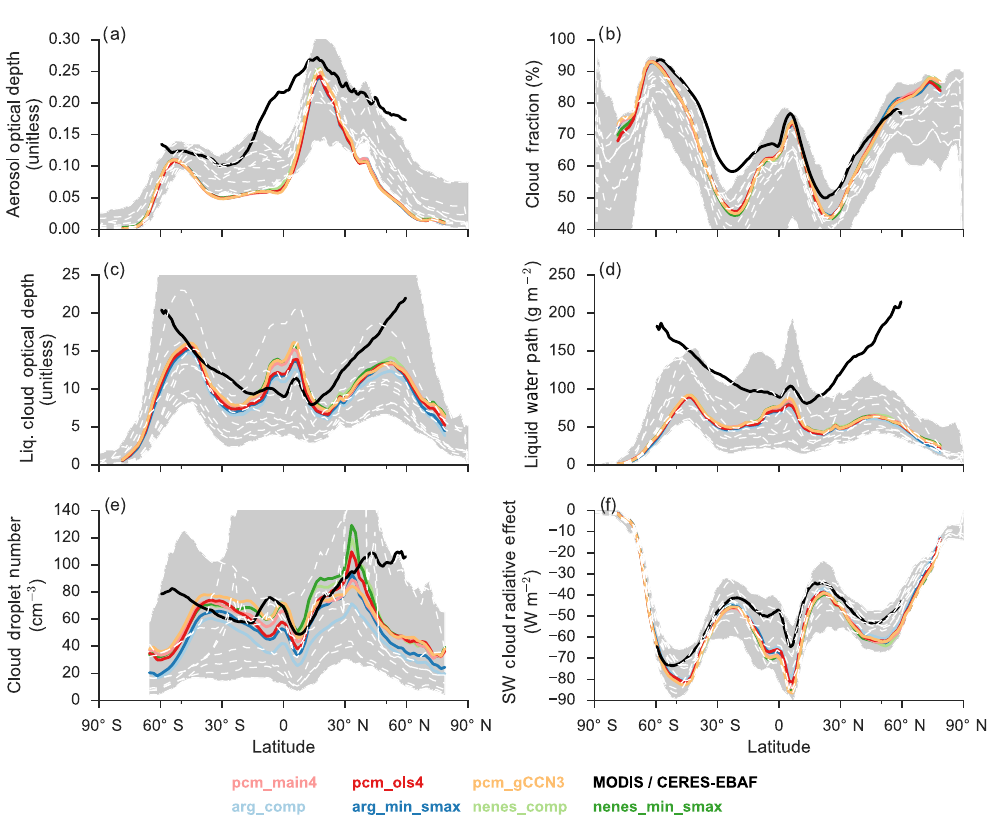
Figure 5. Zonal average aerosol, cloud, and radiation fields under present-day emissions scenario. Colored lines correspond to configurations of MARC using different activation schemes; black lines are derived from CERES-EBAF (SW cloud radiative effect, CRE) and MODIS (all other panels) observations. The shaded gray area corresponds to the inter-model spread for all available models participating in the AeroCom Indirect Effects Experiment; dashed white lines are the zonal averages for each participating model. Cloud droplet number is computed at the cloud top, using only grid cells over the ocean. Here, the SW CRE is computed using the difference between clear-sky and all-sky